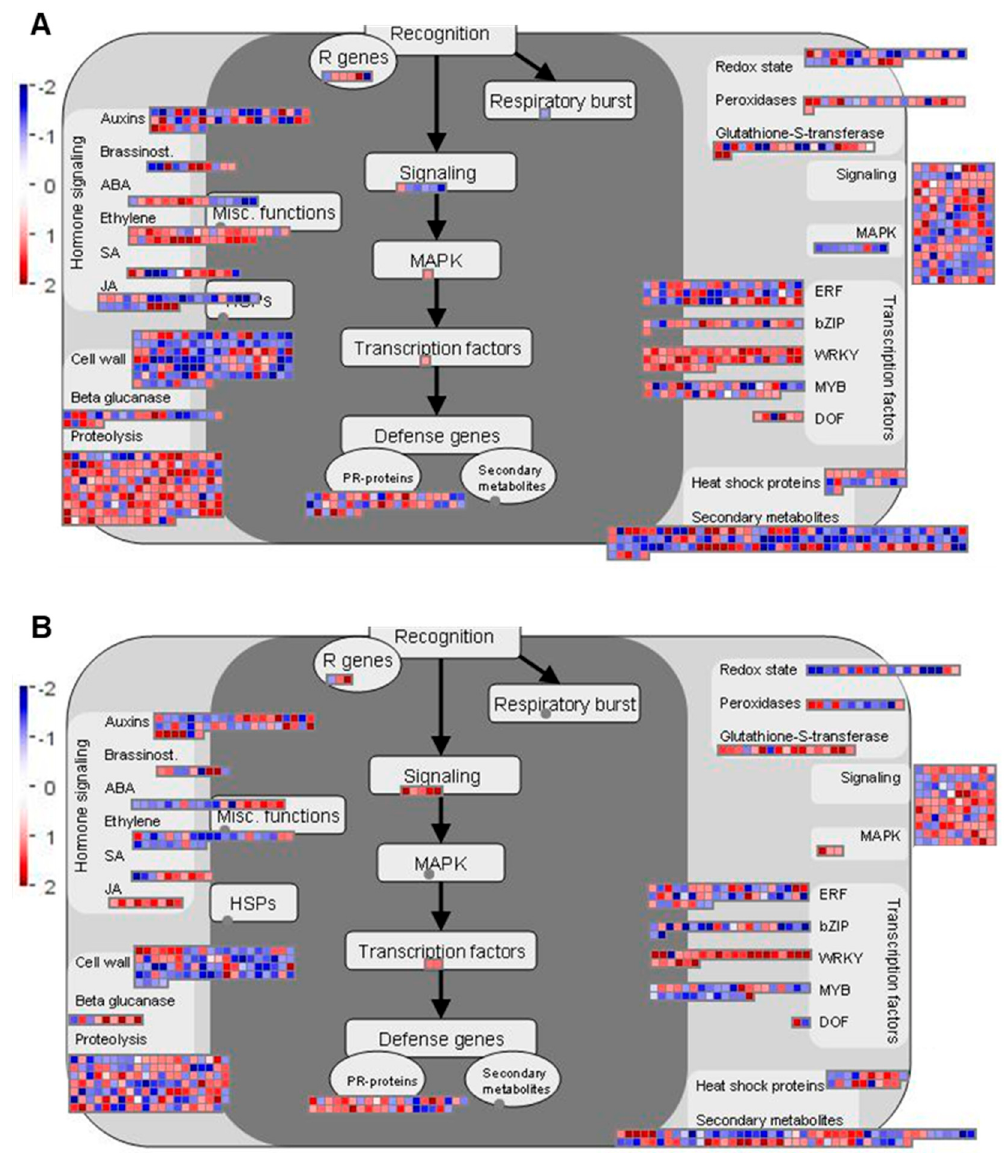
Figure 4. Distribution of differentially expressed genes involved in the biotic stress response in two rutabaga hosts at 7 days after inoculation with Plasmodiophora brassicae . ( A ) ‘Wilhemsburger’ and ( B ) ‘Laurentian.’ The log 2 fold-changes are presented on a scale where red represents upregulation and blue represents downregulation. ABA, abscisic acid; JA, jasmonic acid; SA, salicylic acid; bZIP, basic region-leucine zipper; ERF, APETALA2 / Ethylene-responsive element binding protein family; WRKY, WRKY transcription factor; MYB, MYB transcription factor; DOF, DNA-binding one zinc finger transcription factor; MAPK, mitogen-activated protein kinase; PR-protein, pathogenesis-related protein; R genes, resistance genes.